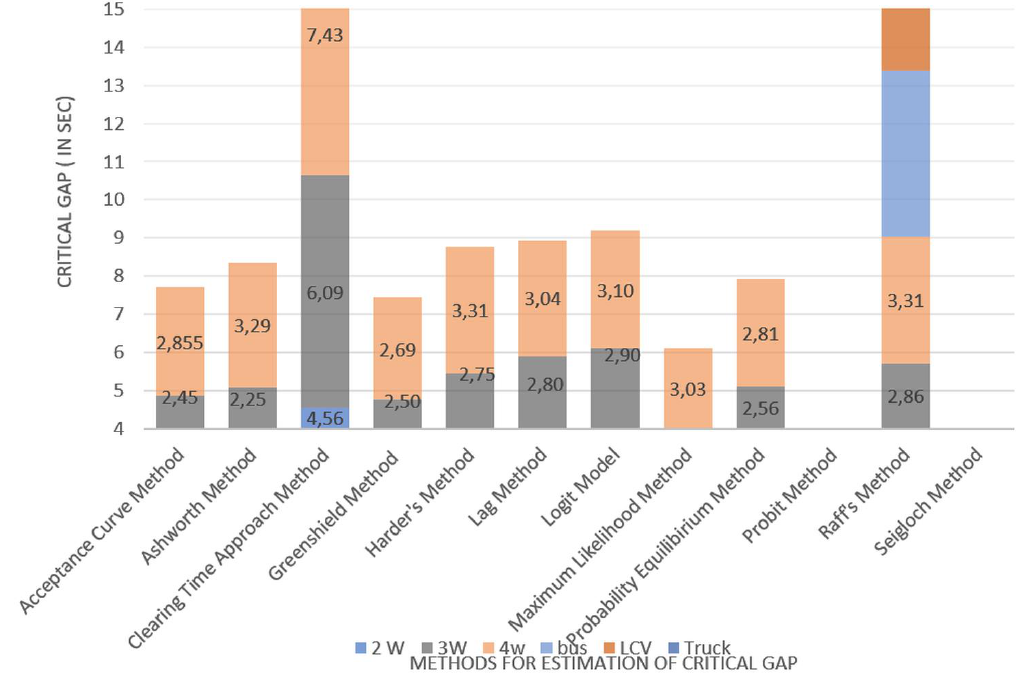
Figure 2: Comparison of methods for estimation of the critical gap for different vehicle types